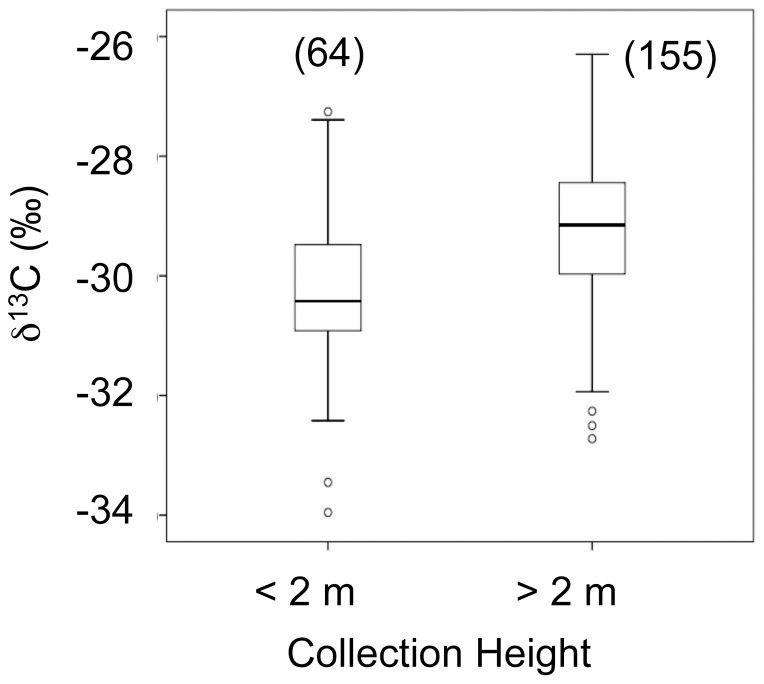
Comparison of foliar δ13C levels below and above 2 meters from the ground.“N” values are presented in parentheses. Foliar δ13C levels were significantly higher for leaves collected above 2 meters from the ground (F1,223 = 36.56, p<0.0001). Removal of outliers did not alter the statistical significance of the test (F1,217 = 37.93, p<0.0001).